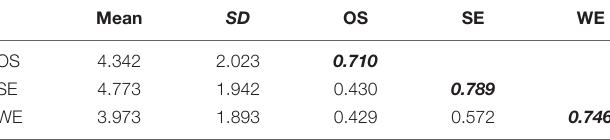
TABLE 3 | Results of discriminant validity testing.